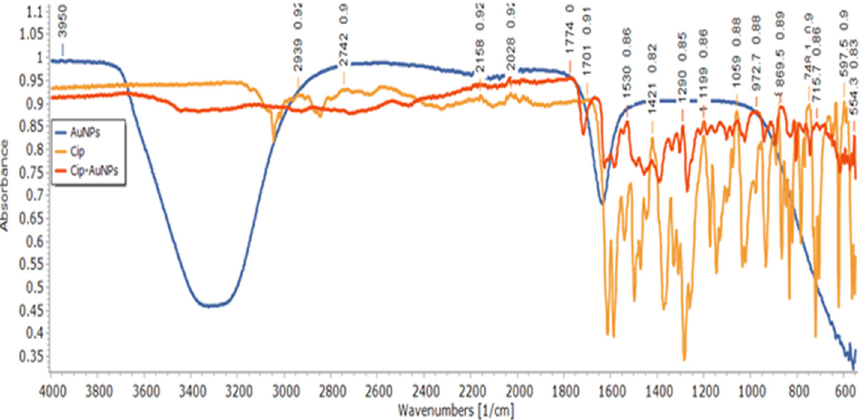
Figure 4. FTIR spectra of CIP-AuNPs, AuNPs, and free CIP.